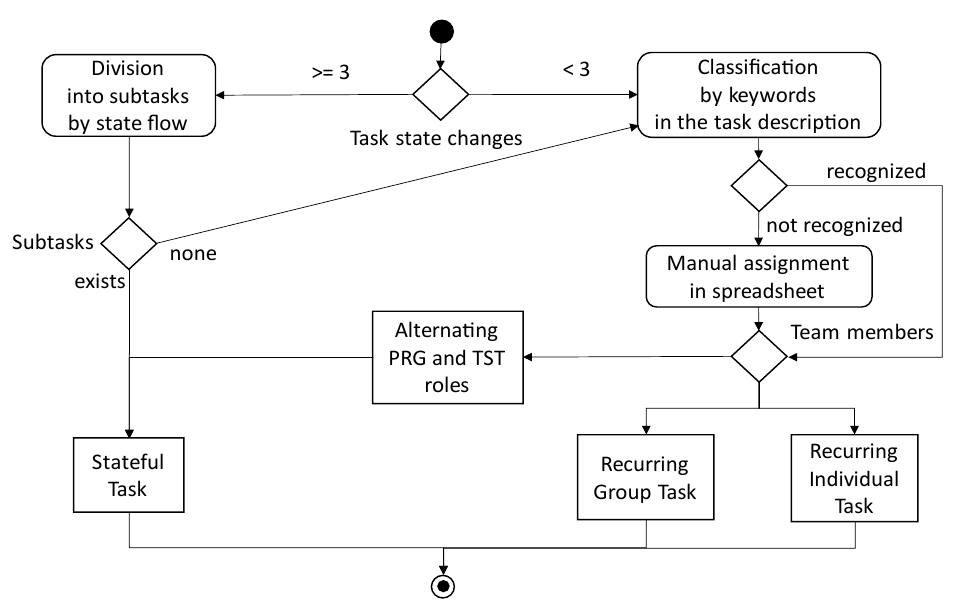
Figure 4. Algorithm of task classification.